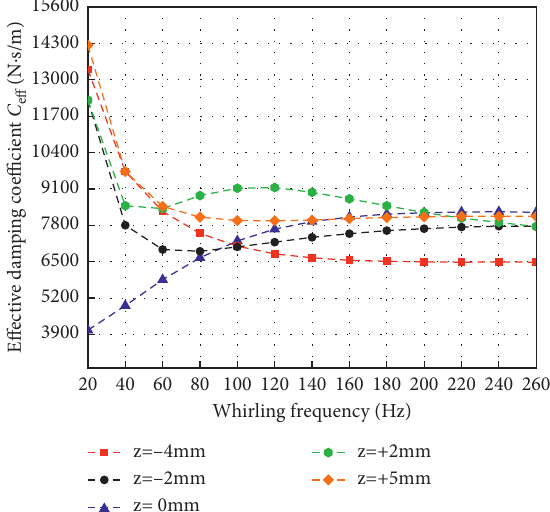
Figure 11: Effective damping coefficient vs. whirling frequency.